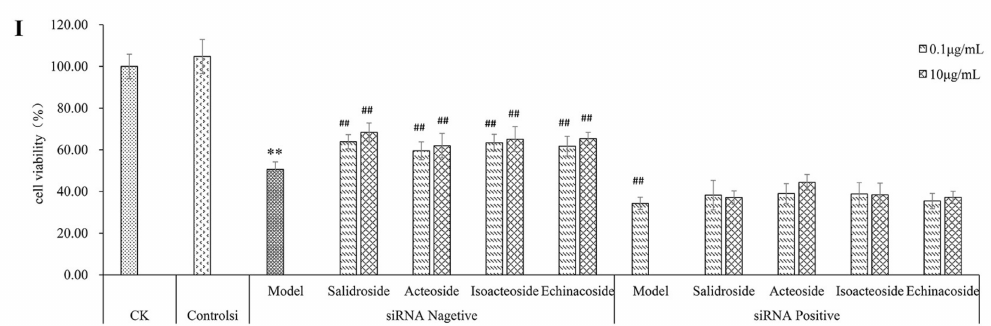
Figure 5. Protective effect of PhGs on Nrf2 in H 2 O 2 -treated PC12 cells. ( A ) The expression of Nrf2 protein in cytoplasm was detected by immunoblotting using specific antibody. β -Actin was used as loading control. ( B ) The quantitative densitometric analysis of Nrf2 protein in cytoplasm. ( C ) The expression of Nrf2 protein in the nucleus was detected by immunoblotting using